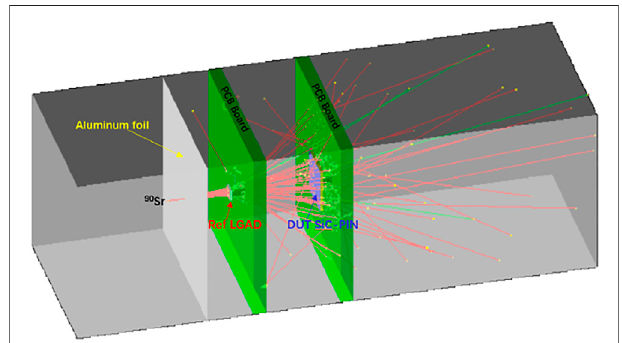
FIGURE 6 | Scattering of β particles with 2.28 MeV after the aluminum foil and LGAD in GEANT4 simulations. The fi gure shows the tracks of 50 incident particles going through the entire β source test system.